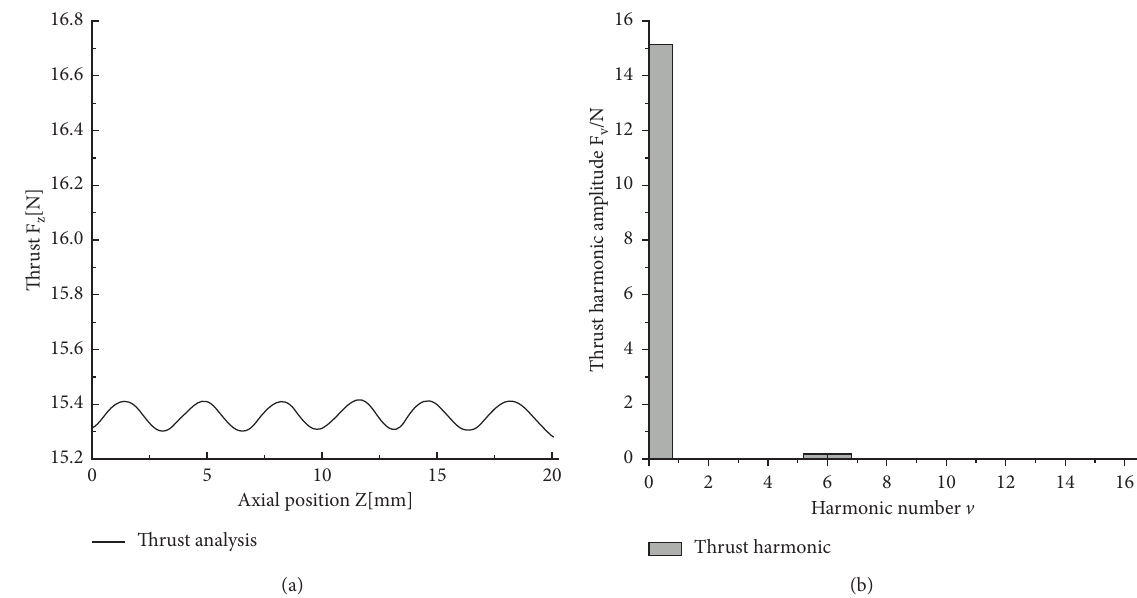
Figure 11: Comparison of motor thrust: (a) motor thrust analysis diagram; (b) motor thrust harmonic analysis diagram. Table 2: Thrust harmonic content of the new motor. Table 3: Optimized structural parameters of the new motor. Harmonic distortion Harmonic number v Thrust F z (N)